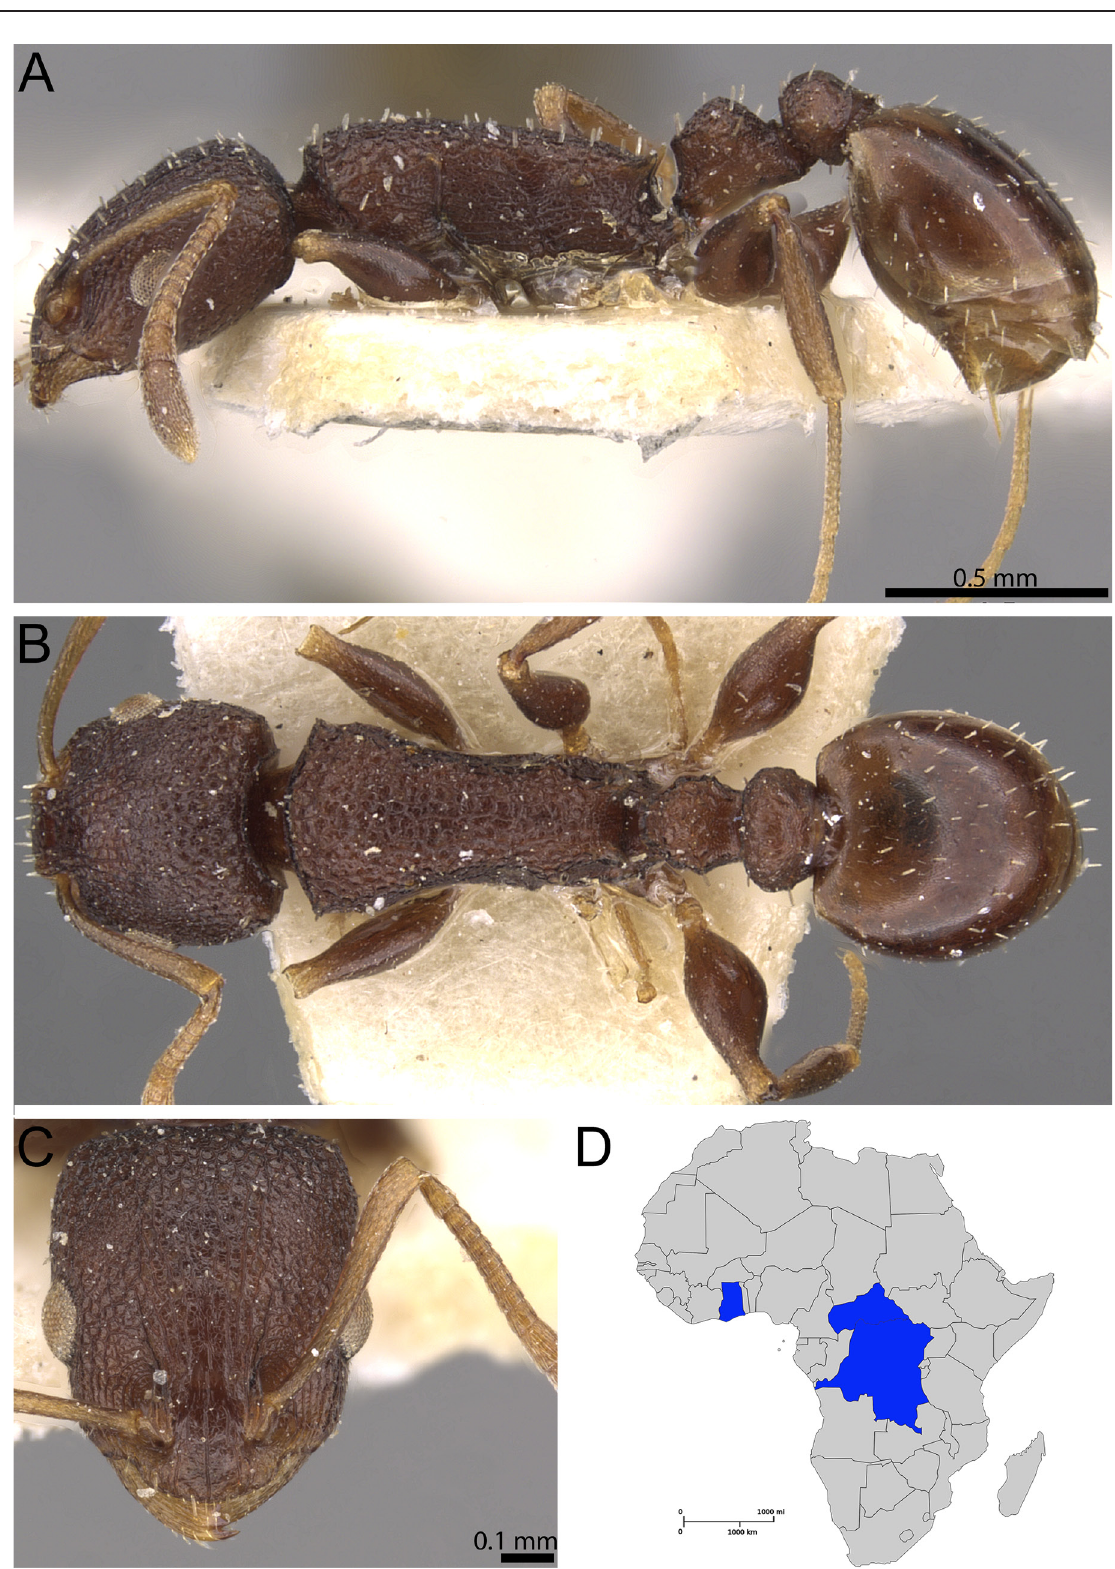
Fig. 17. Nesomyrmex grisoni (Forel, 1916) (CASENT0908994). A . Body in profile view. B . Body in dorsal view. C . Head in full-face view. D . Map of Africa and Madagascar showing currently known